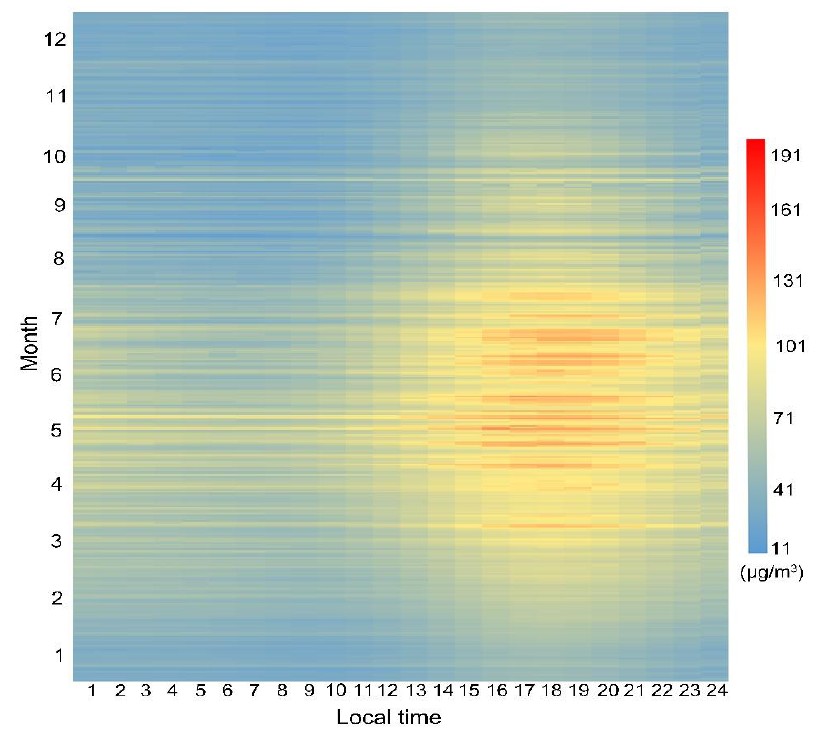
Figure 5. The stacked graph of hourly values of observed surface O 3 from 2015 to 2019.